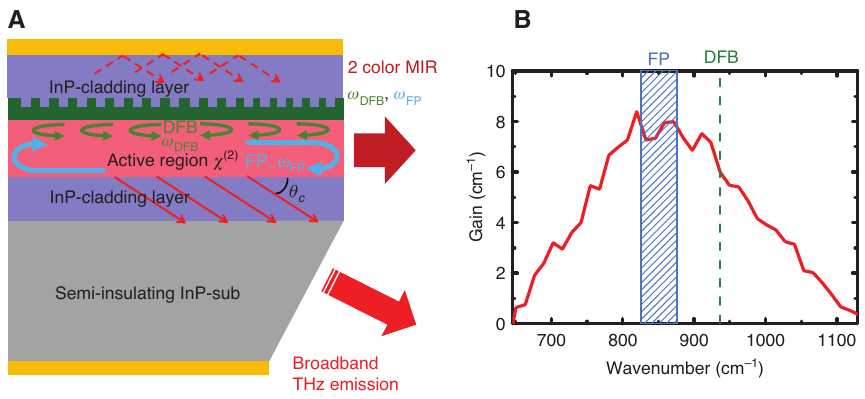
Figure 5: Working principle of DFB/FP device. (A) Schematic of a DFB/FP THz DFG-QCL. (B) Gain curve of the DAU active region designs and spectral positions of a single mid-IR pump frequency selected by a DFB grating and FP modes of the second mid-IR pump selected by the laser